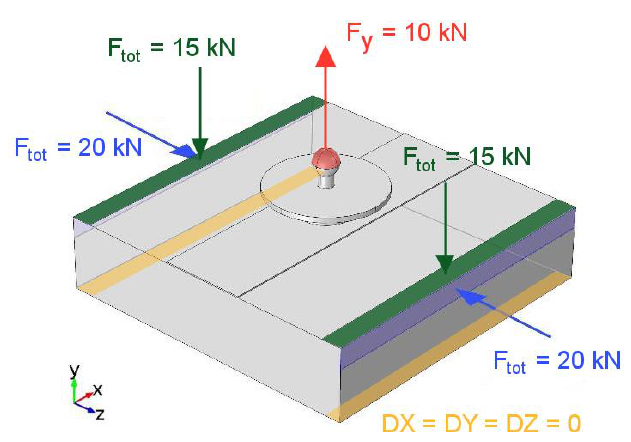
Figure 6. Applied boundary conditions for the simulated ND pull-off test.